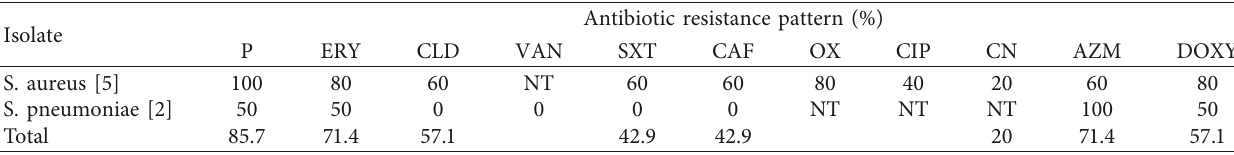
Table 5: Antibiotic susceptibility pattern of Gram-positive bacterial pathogens to tested antibiotics in patients with AECOPD at JUMC, southwest Ethiopia, 2019. Isolate